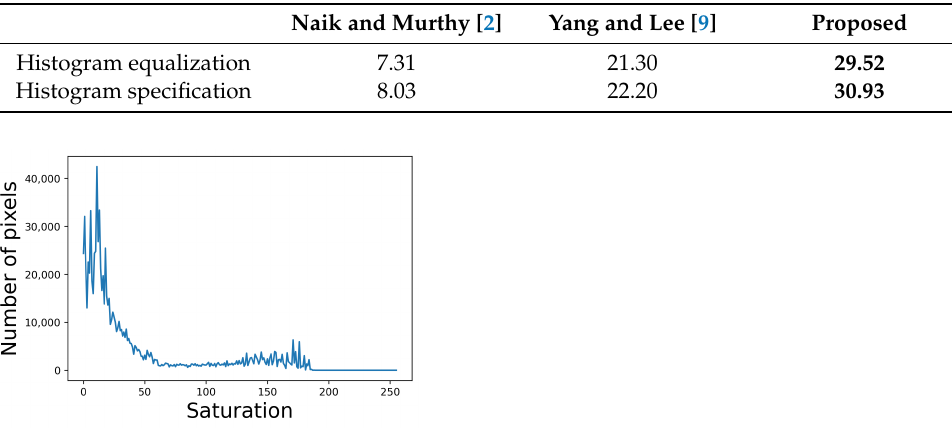
Figure 16. Saturation histogram of image No. 3 enhanced by the proposed method with